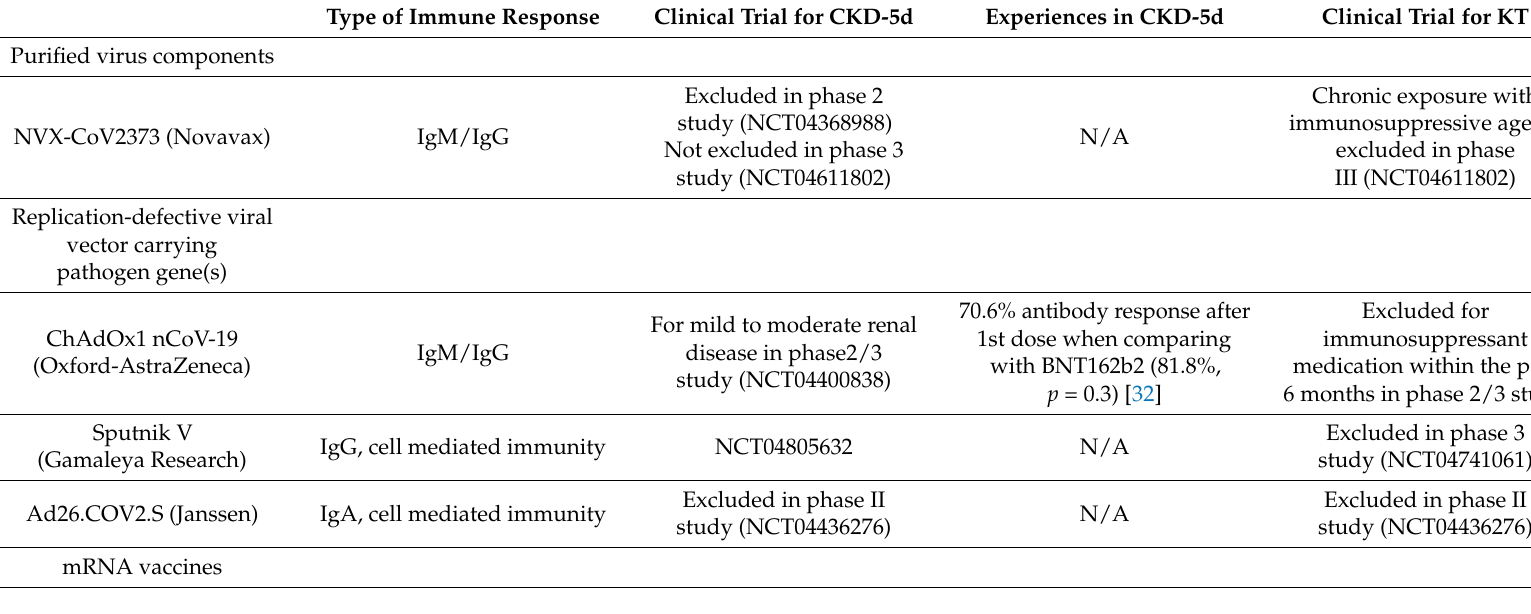
Table 1. The SARS-CoV2 vaccine in CKD-5d and kidney transplantation (KT) in clinical trials and